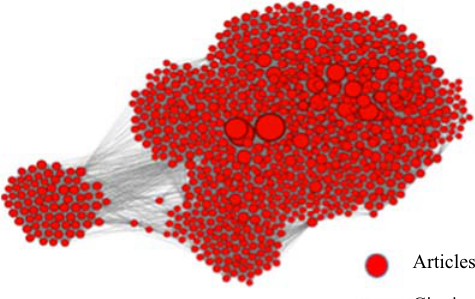
Figure 4. Force Atlas layout of 960